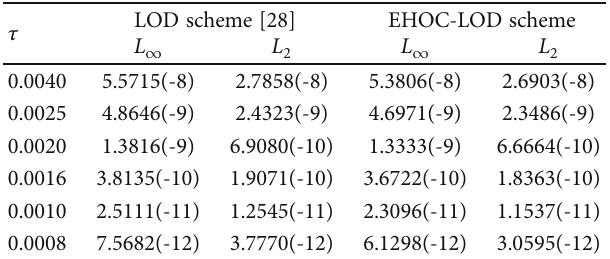
Table 3: L and L ∞ norm errors when T = 0 : 02 and the CFL 2 number is fi xed at 0.2 for Example